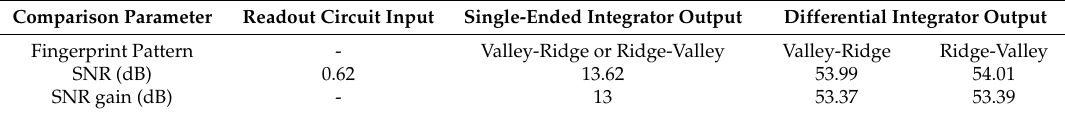
Table 4. SNR for Different Cases of Finger Features.